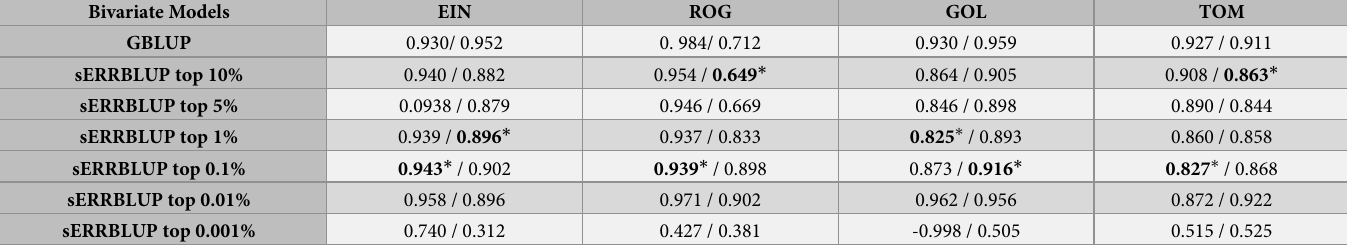
Table 3. Genomic correlation between 2017 and 2018 in each environment for trait PH_V4 for KE (blue numbers) and PE (red numbers). The blue and red bold numbers with stars indicate which proportion of interactions in bivariate sERRBLUP maximized the predictive ability based on haplotype blocks in each environment for KE and PE, respectively.